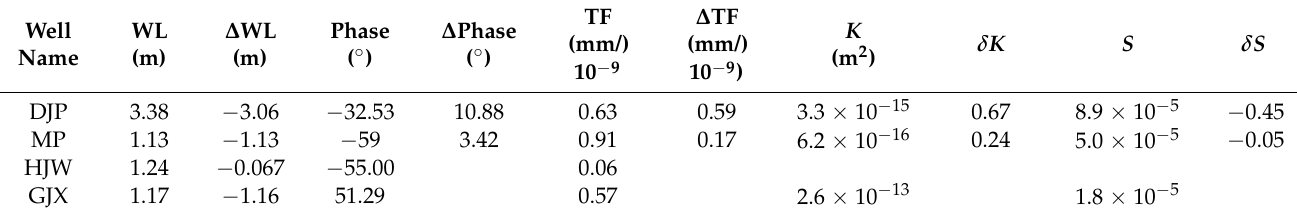
Table 3. Water level, tidal behavior and hydraulic properties before and after the Wenchuan M W 7.9 earthquake.